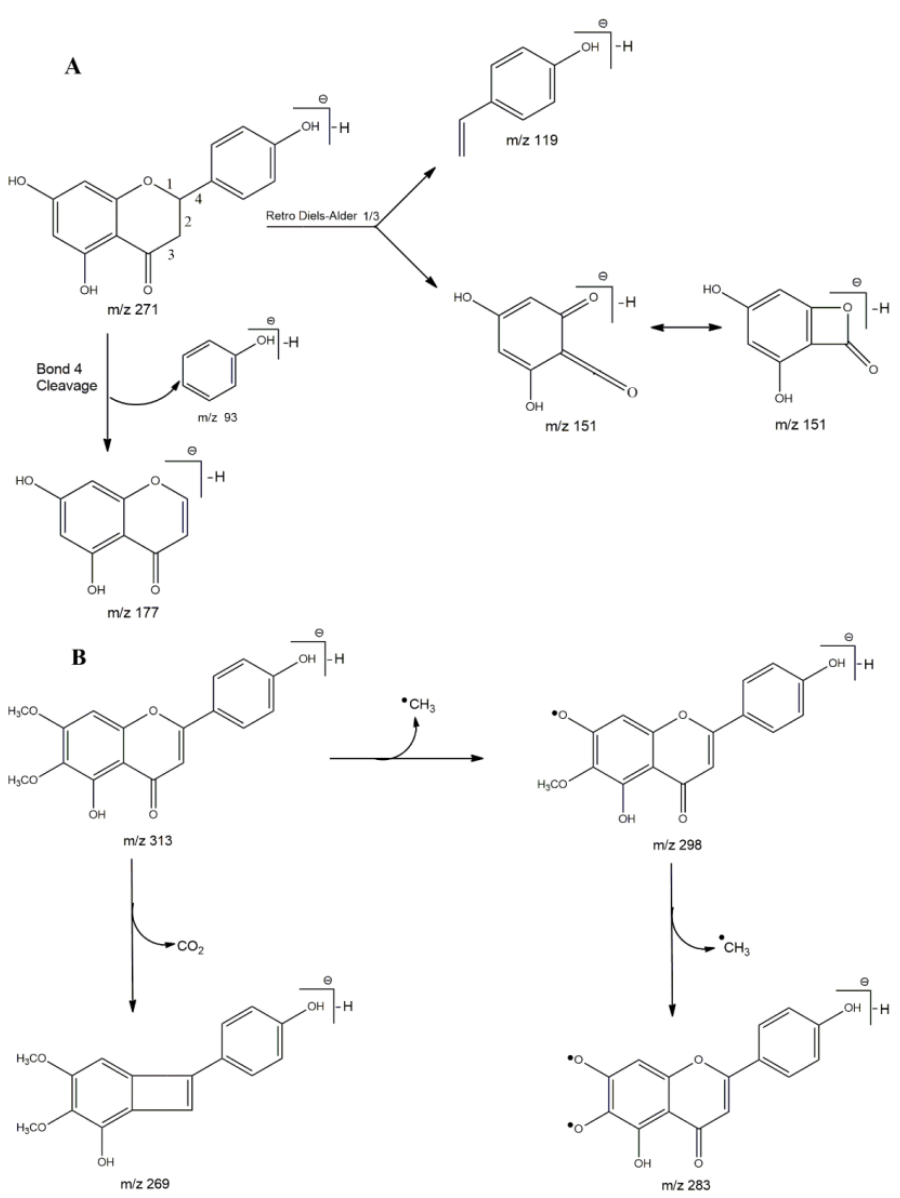
Figure 1. Proposed fragmentation pattern for deprotonated naringenin ( A ) and cirsimaritin ( B ). The results show that LaEE has a significantly higher content of total phenolics of 30.11 ± 1.24 mg GA/g Ext., followed by LgEE and LsEE (Table 2). Studies show a high phenolic content for ethanolic, methanolic, and aqueous extracts of L. alba leaves, with 117.78 ± 2.69, 367.49 ± 38.90, and 505.11 ± 2.55 µ g GAE/g dry weight, respectively [53]. Garmus et al. [54], studying the influence of different types of extraction on the phe- nolic composition of L. siodides , obtained contents ranging between 38.20 ± 0.06 and 230.5 ± 0.1 mg GAE/g